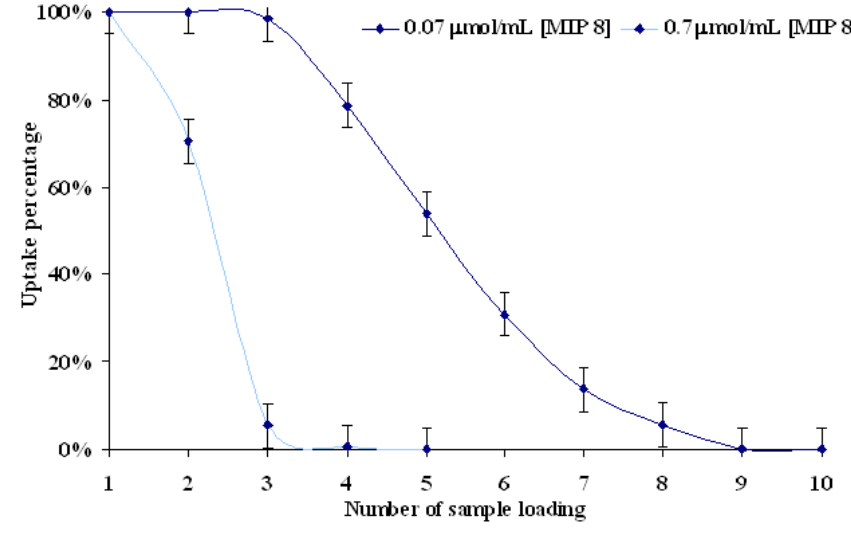
Figure 5 . Study of complete saturation of MIP8 at different concentrations of aqueous molsidomine standard